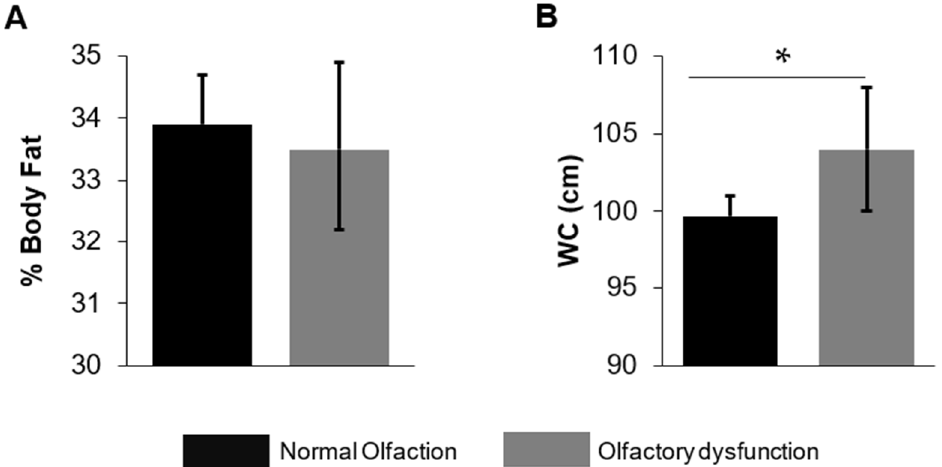
Figure 1. ( A ) Comparison of body fat percent (%) measured using dual-energy X-ray absorptiom- etry between the two olfactory groups. ( B ) Comparison of waist circumference measured using a measuring tape between the two olfactory groups. * p < 0.05 and error bars represent 95% CI.